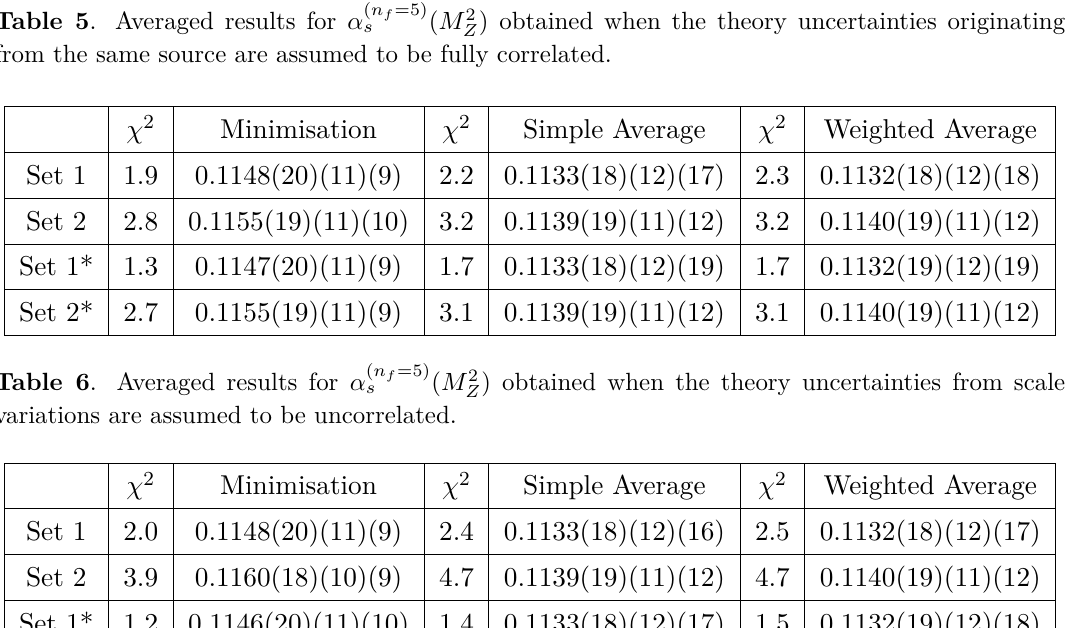
Table 7 . Averaged results for α ( n f =5) s ( M 2 assumed to be uncorrelated.